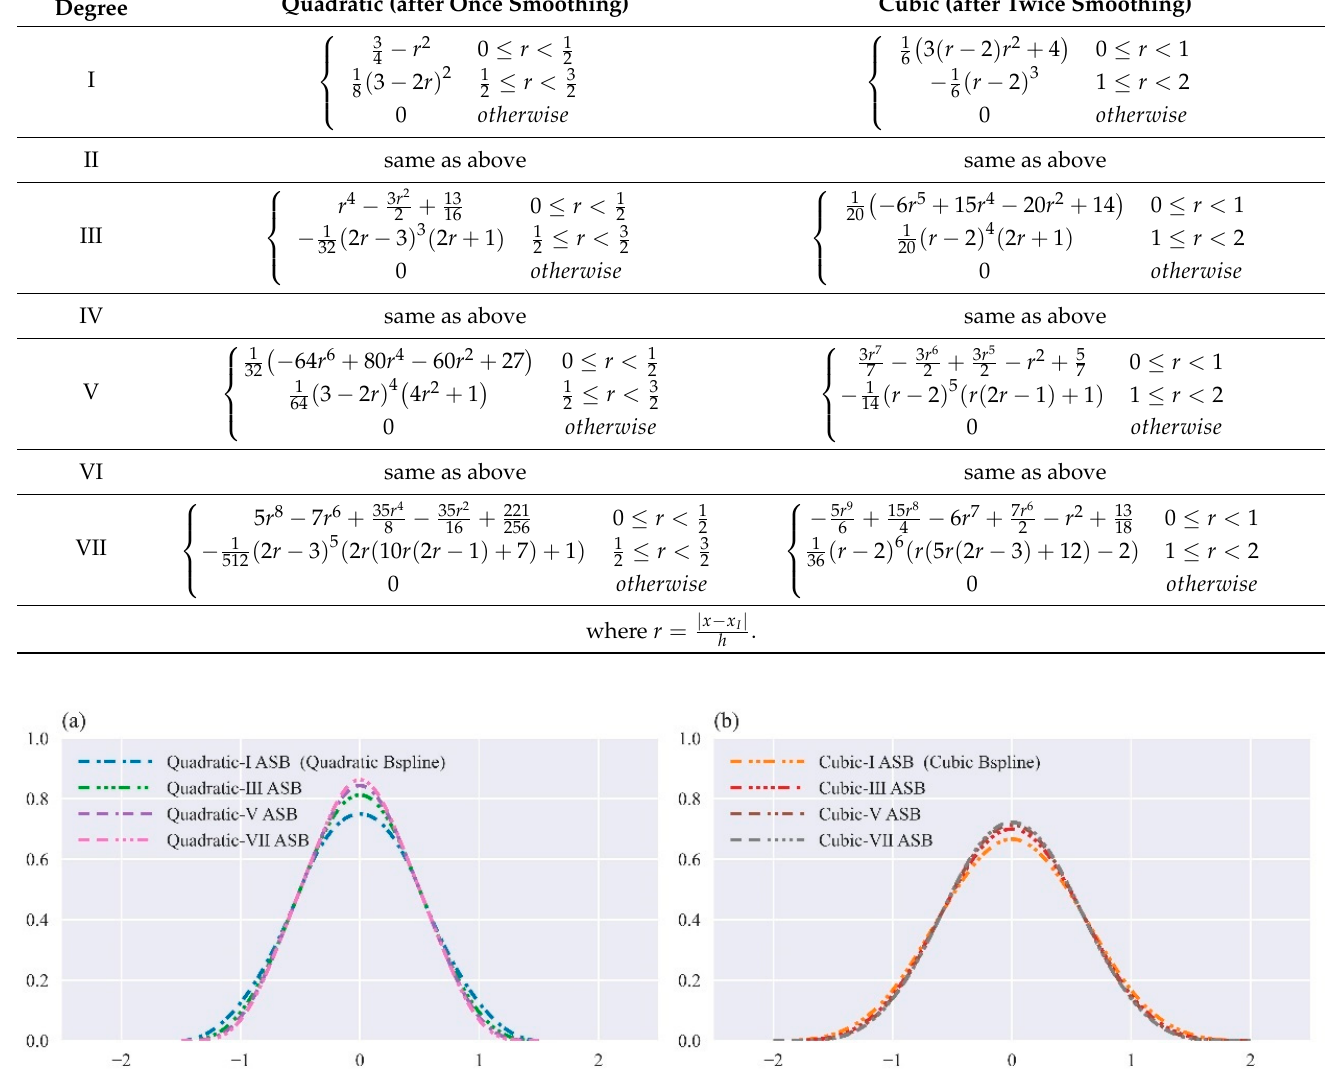
Figure 4. Typical aggregated-smoothed Bernstein shape functions: ( a ) the quadratic, ( b ) the cubic. Quadratic B-spline and cubic B-spline are exactly the lowest-level cases of the ASB hierarchy.